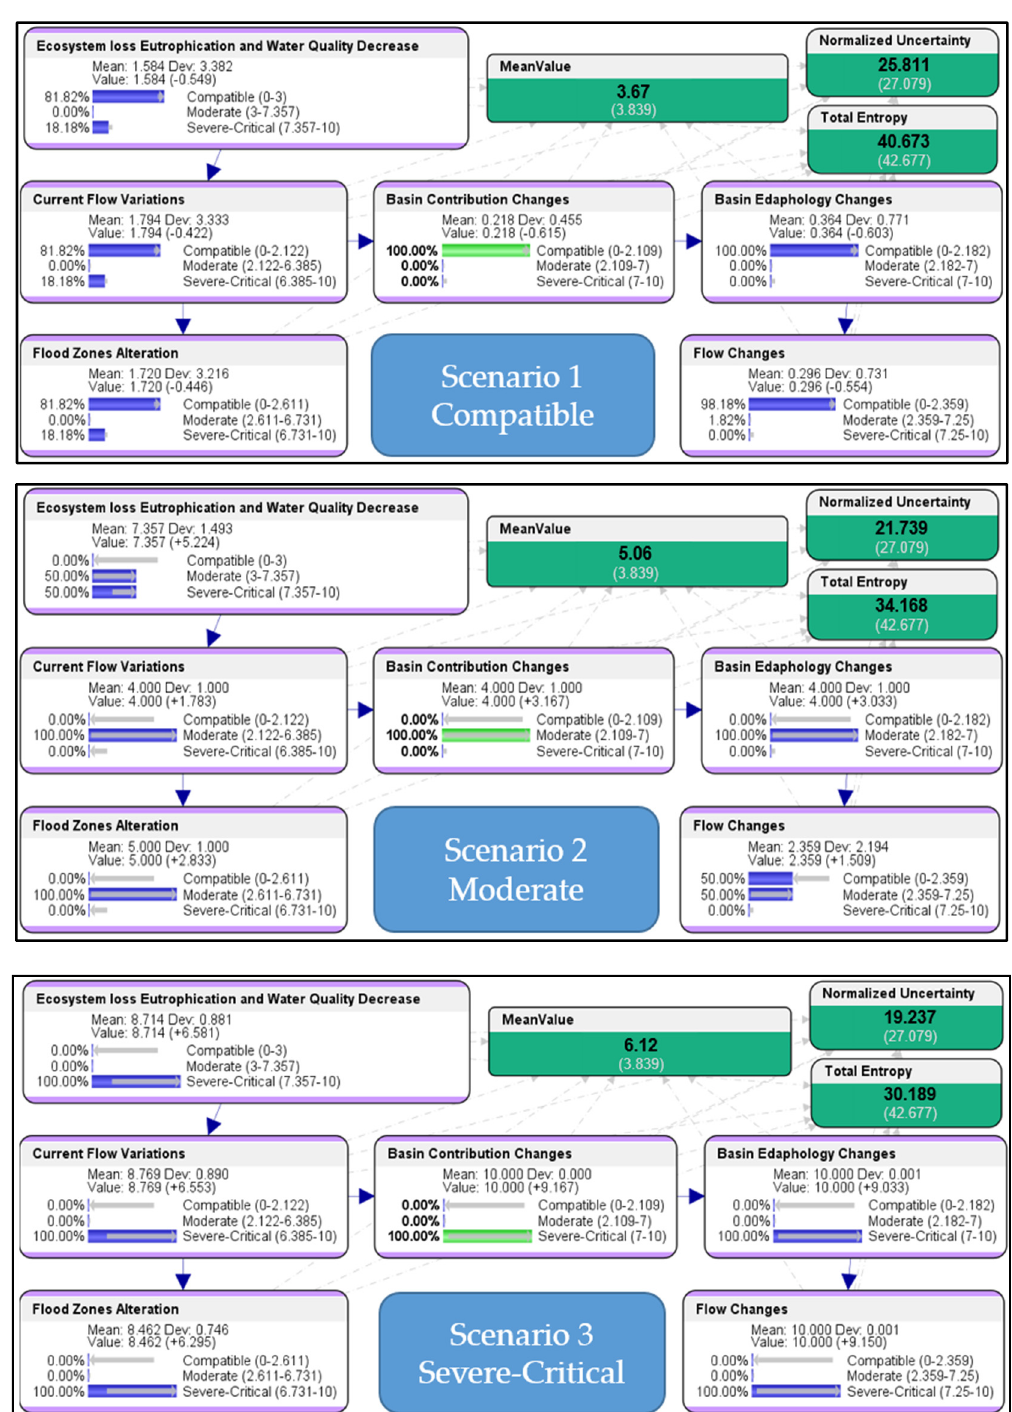
Figure 5. A priori probabilities for the variables before conducting inference analysis.